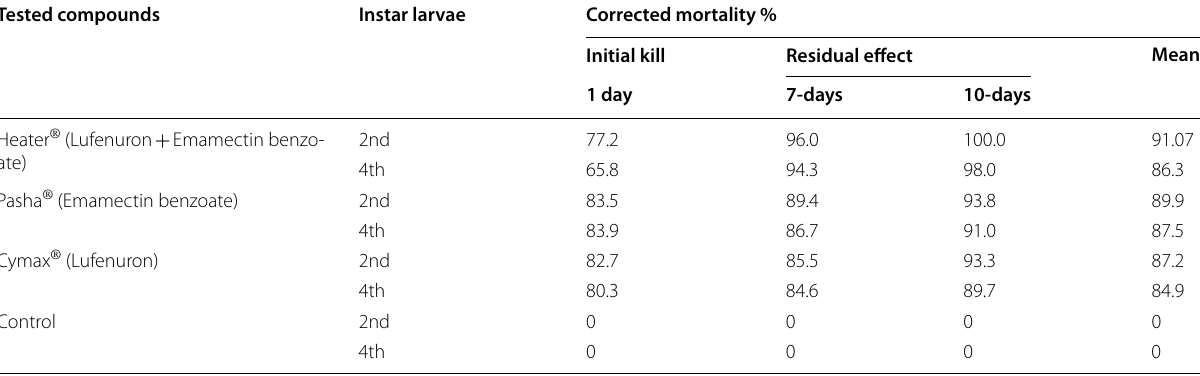
Table 3 The corrected larval mortality percentage of the 2nd and 4th instar larvae of the cotton leafworm S. littoralis after treatment with the tested compounds during 2020 growing season in Beheira governorate Tested